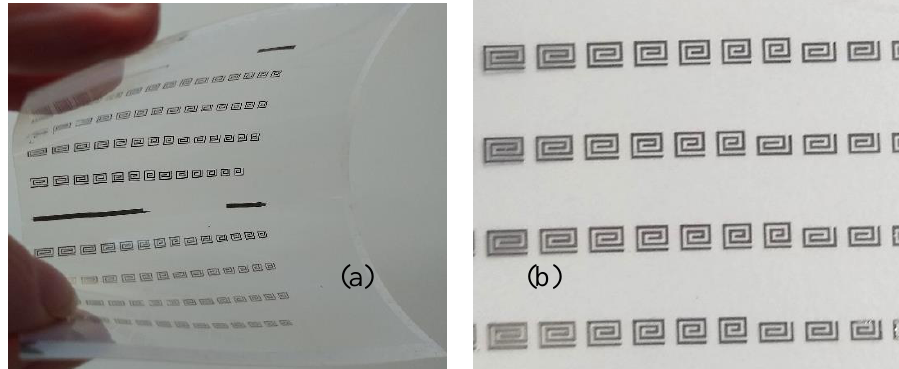
Figure 19. ( a ) Ink-jet printed resonators arrays on polyethylene terephthalate substrate realized with highly conductive Ag-nanoparticles ink. ( b ) Detail of the same sample.